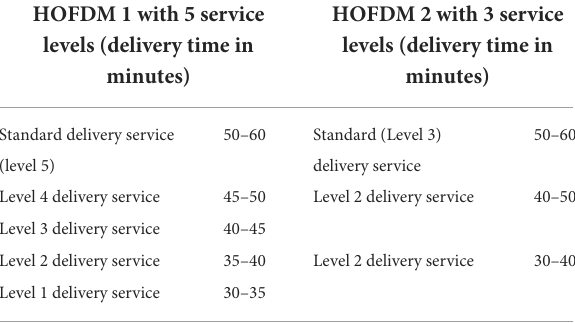
TABLE 4 Candidate HOFDMs with 5 and 10min